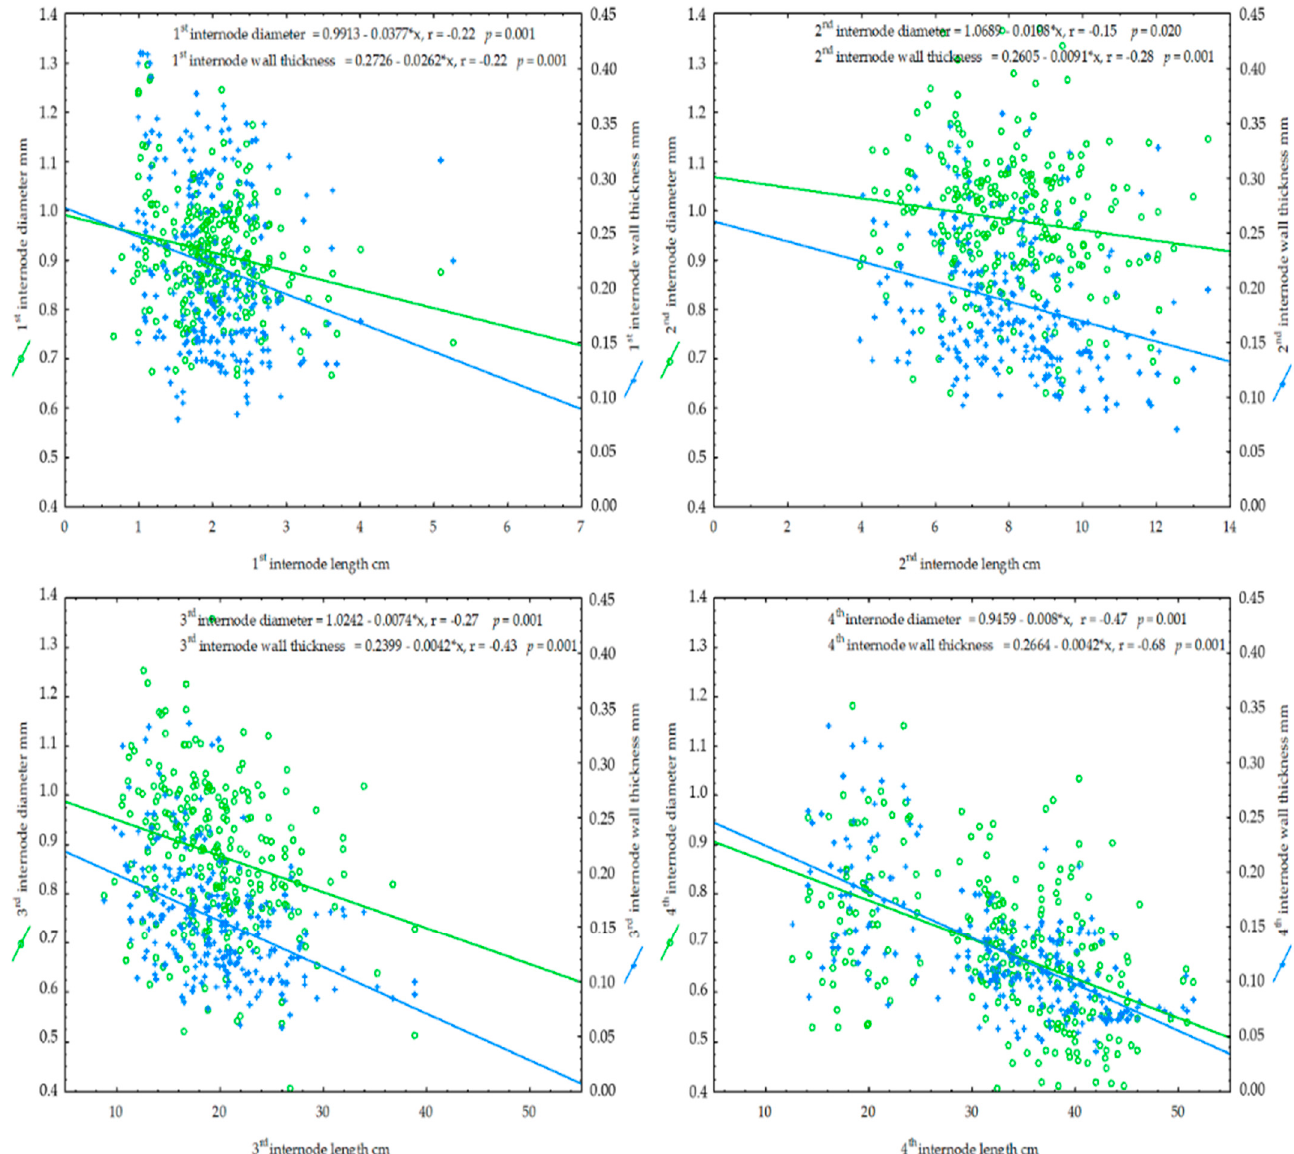
Figure 1. Relationship between length and diameter and wall thickness of successive internodes of red fescue ( Festuca rubra ssp. rubra cv. Nista and F . r . ssp. commutata cv. Dorosa).